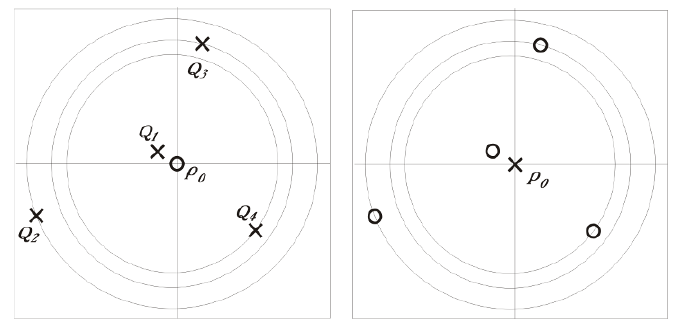
Figure 1. Reformulation of the problem, the shotpoints replace the